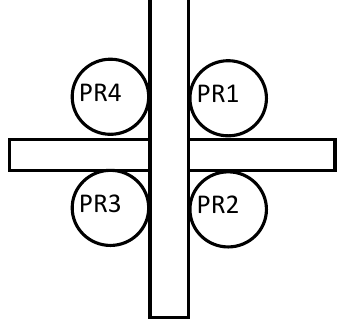
Figure 3. Pointing device. Top view.